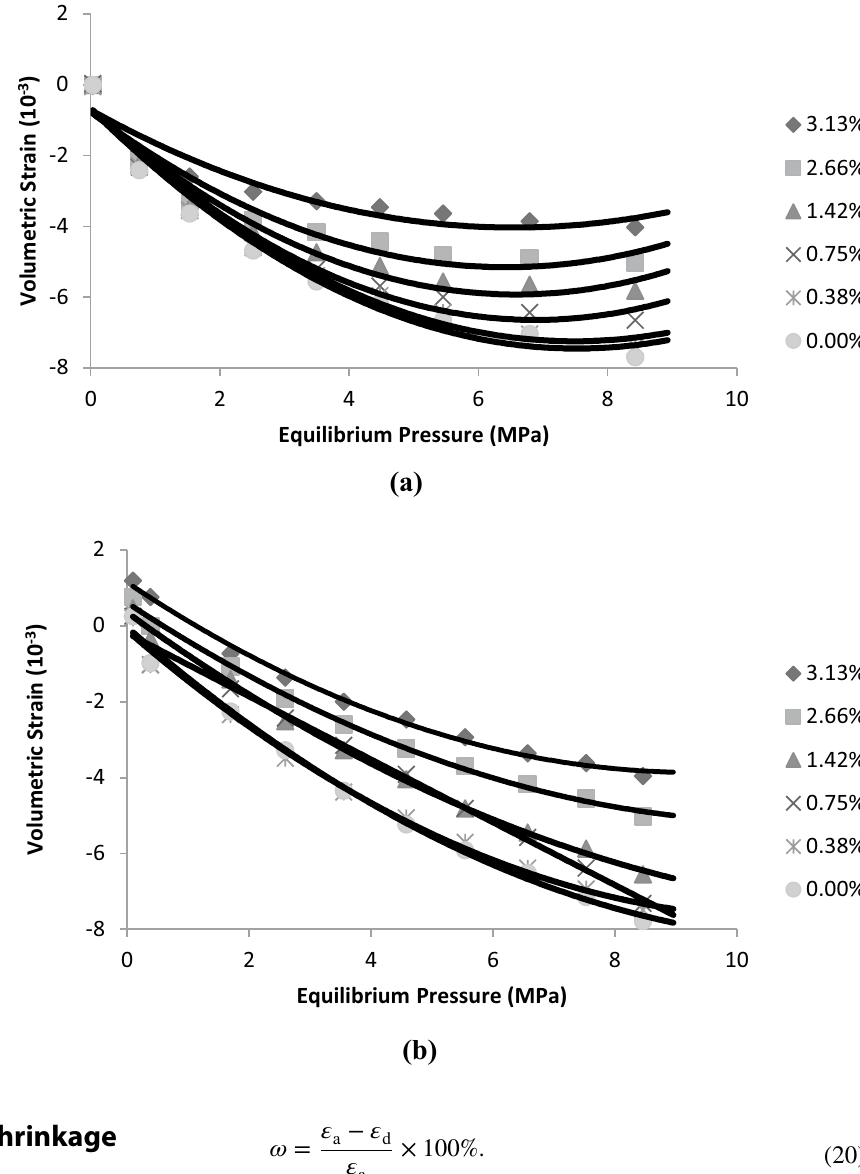
Fig. 3 Representing modified curves of volumetric strain of coal particles under various moisture contents: a swelling and b